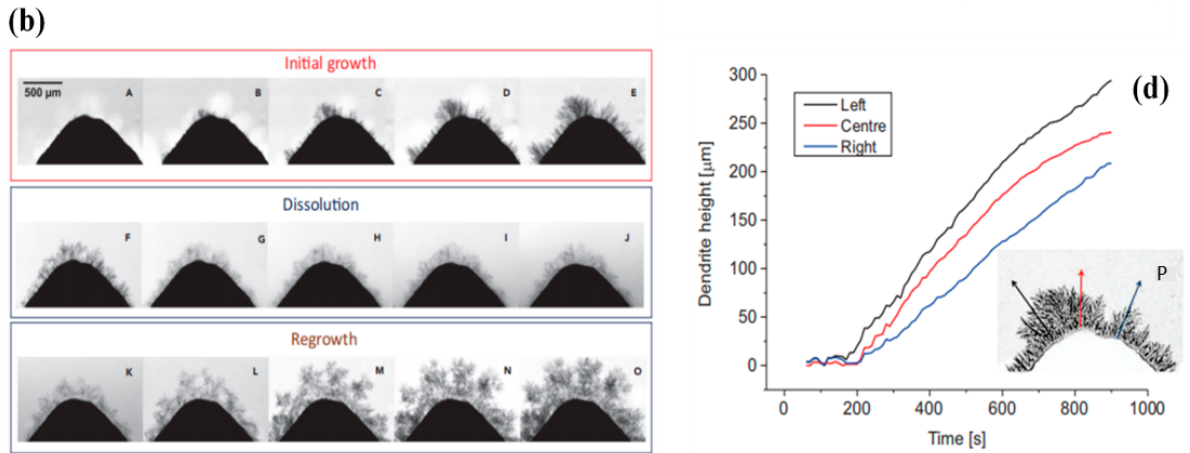
Figure 2. ( a ) Diagrammatic sketch of the growth and nucleation processes of Zn dendrites; reproduced under terms of the CC-BY license [76]. Copyright 2020, Frontiers. ( b ) The growth and dissolution of Zn dendrite at various points of time corresponding to ( c ); ( c ) chronopotentiometric curve of the zinc plating–stripping process according to the radiography measurements; ( d ) growth curves at three positions by probing the growth of the dendrite directly. Reproduced with permission from [77]. Copyright 2019, Elsevier.